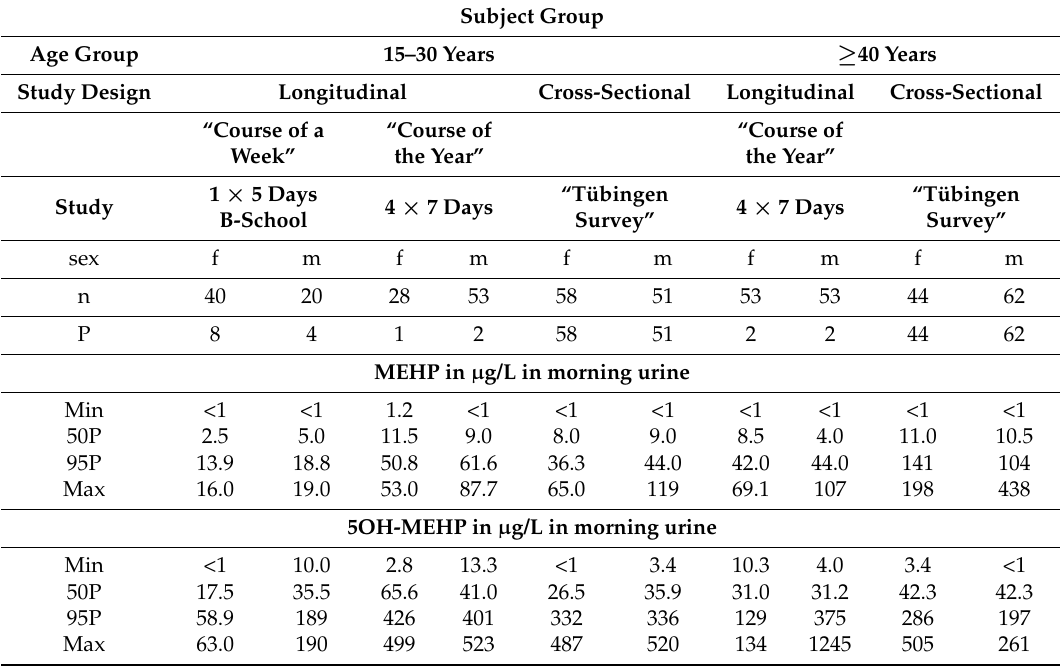
Table 1. Minimum, median (50th percentile), 95th percentile, maximum for urinary concentrations